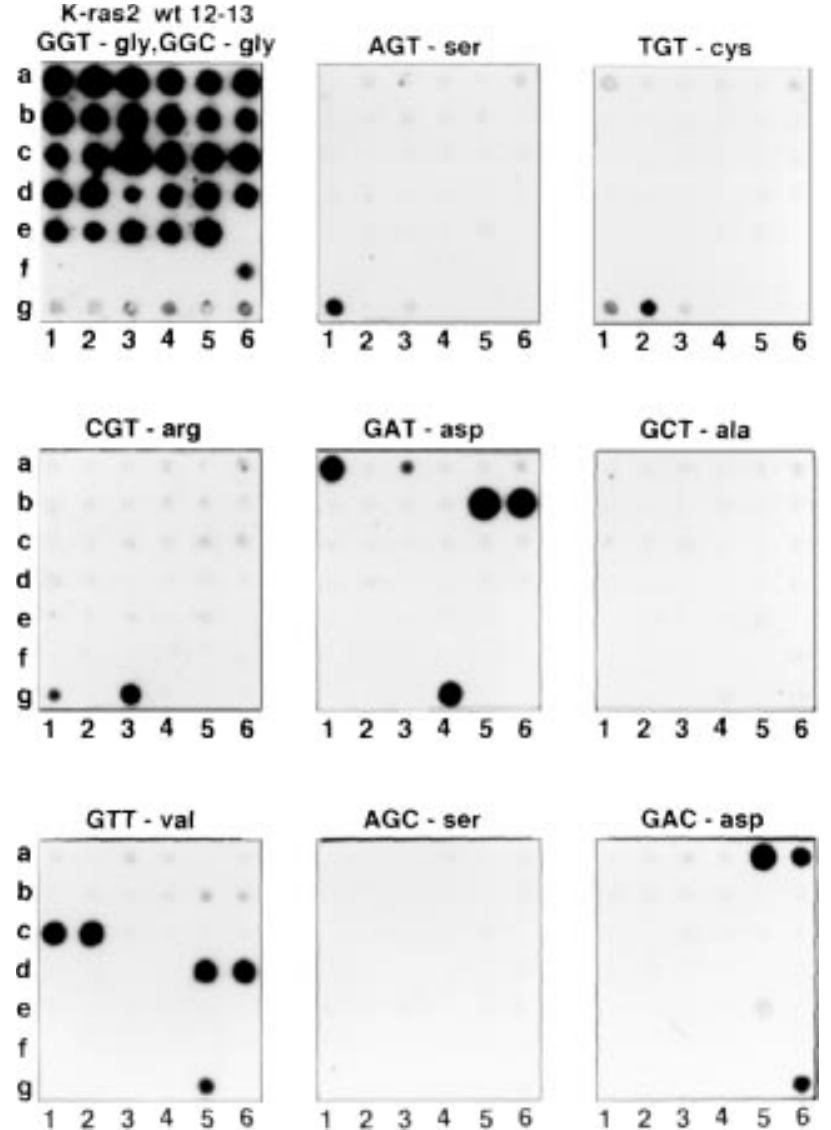
Fig. 1. Examples of k-ras mutation spectrum analysis for the adenomatous (A) and carcinomatous (C) components of human colorectal adenomas containing early cancer (A/C, as listed in Tables 1 and 3). Wild type k-ras results in codons 12 and 13, which correspond in both cases to the aminoacid glycin, are shown in the top-left rectangle (wt 12–13 GGT-gly, GGC-gly). Peripheral blood lymphocytes from a healthy donor were used as a k-ras wild type control (spot f6). The pairs of spots (a1–a2), (a3–a4), (a5–a6), (b1–b2), and so on up to (e3–e4) correspond to the wild type cases listed in Tables 1 and 3 under N. 24, 25, 26, 22, 23, 5, 14, 2, 8, 12, 13, 21, 16 and 1. An additional wild type case (the A component of case N. 6) corresponds to spot e5. The light grey spots g1–g6 correspond to 6 cell lines (respectively, A549, SW837, NIH3T3, SKLU-1, SW480 and DLD1) which had specific k-ras mutations in at least one allele. The cases with mutations are shown in the other rectangles: the 6 possible mutations in codon 12 (AGT-ser, TGT-cys, CGT-arg, GAT-asp, GCT-ala, GTT-val) and the 2 most common mutations in codon 13 (AGC-ser, GAC-asp). Specific k-ras mutation controls were obtained using mutated cell lines: the A549 cell line with heterozygous AGT mutation (g1); the SW837 cell line with heterozygous TGT mutation (g2); the NIH3T3 cell line with transfected CGT human mutated k-ras (g3); the SKLU-1 cell line with heterozygous GAT mutation (g4); the SW480 cell line with homozygous GTT mutation (g5); the DLD-1 cell line with heterozygous GAC mutation (g6) [15]. Identical k-ras mutations for the adenomatous and carcinomatous components of 4 human colorectal adenomas containing early cancer (these cases are listed in Tables 1 and 3 under the cases N. 4, 14, 21 and 26) corresponding to the pairs of spots GAT (b5–b6), GTT (c1–c2), GTT (d5–d6), and GAC (a5–a6) may be